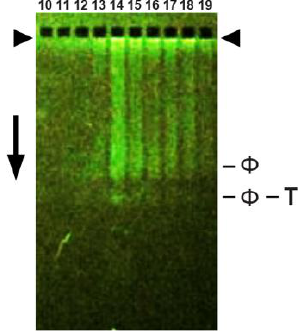
Figure 5. Bleomycin-loading of phage T4, assayed by rate zonal centrifugation, followed by AGE. AGE for 15.5 h is shown of the fractions of the sucrose gradient. A preparation more concentrated than in Figure 2 was used. Fluorescence was imaged with the green emission filter. The contrast was digitally enhanced. The arrowheads indicate the origins of electrophoresis; the arrow indicates the direction of electrophoresis. The titers of gradient fractions were the following (fraction number, followed by titer × 10 10 PFU/mL: 7, 0.023; 8, 0.015; 9, 0.021; 10, 0.035; 11, 0.030; 12, 0.017; 13, 9.0; 14, 150; 15, 77.6; 16, 54.3; 17, 43.3; 18, 34.7.